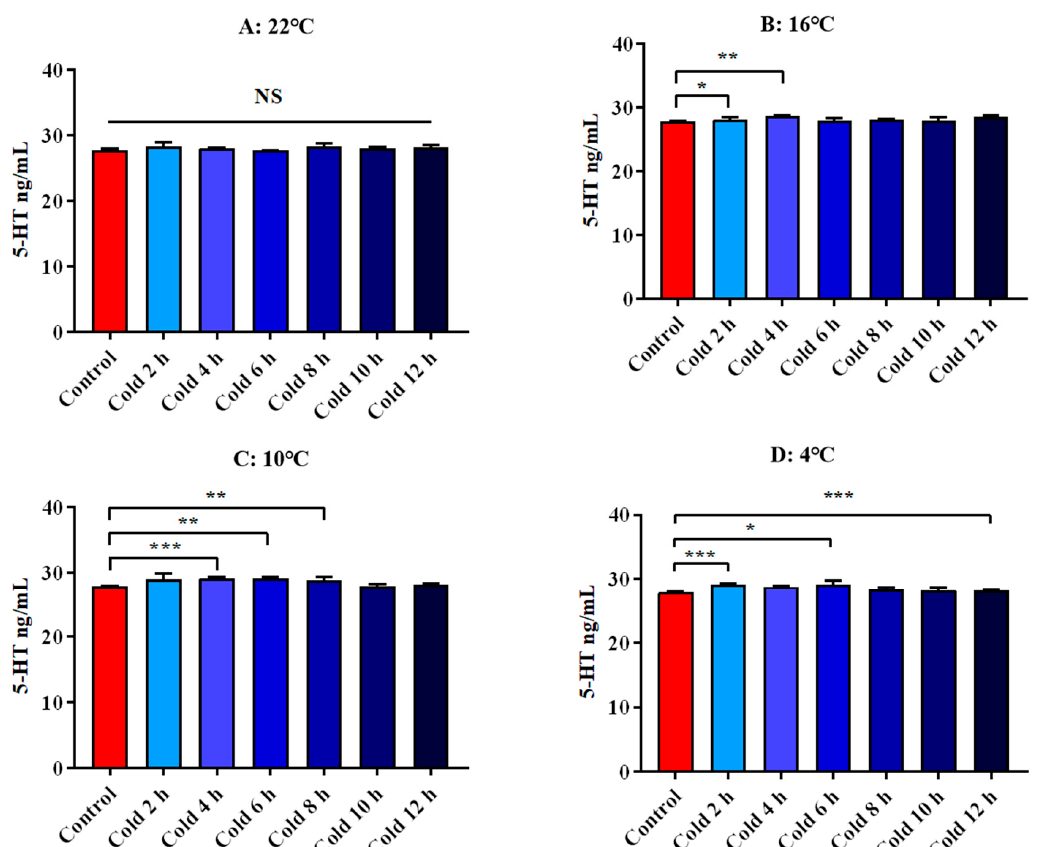
Figure 12. Changes of serum 5-HT of ICR mice under different intensity of cold exposure. ( A ). Changes in the serum 5-HT of mice under cold exposure at 22 ◦ C; ( B ). Changes in serum 5-HT of mice under cold exposure at 16 ◦ C; ( C ). Changes in the serum 5-HT of mice under cold exposure at 10 ◦ C; ( D ). Change in the serum 5-HT of mice under cold exposure at 4 ◦ C. Compared with 28 ◦ C normal temperature control group, the difference was significant as * p < 0.05. ** p < 0.01. *** p < 0.001.